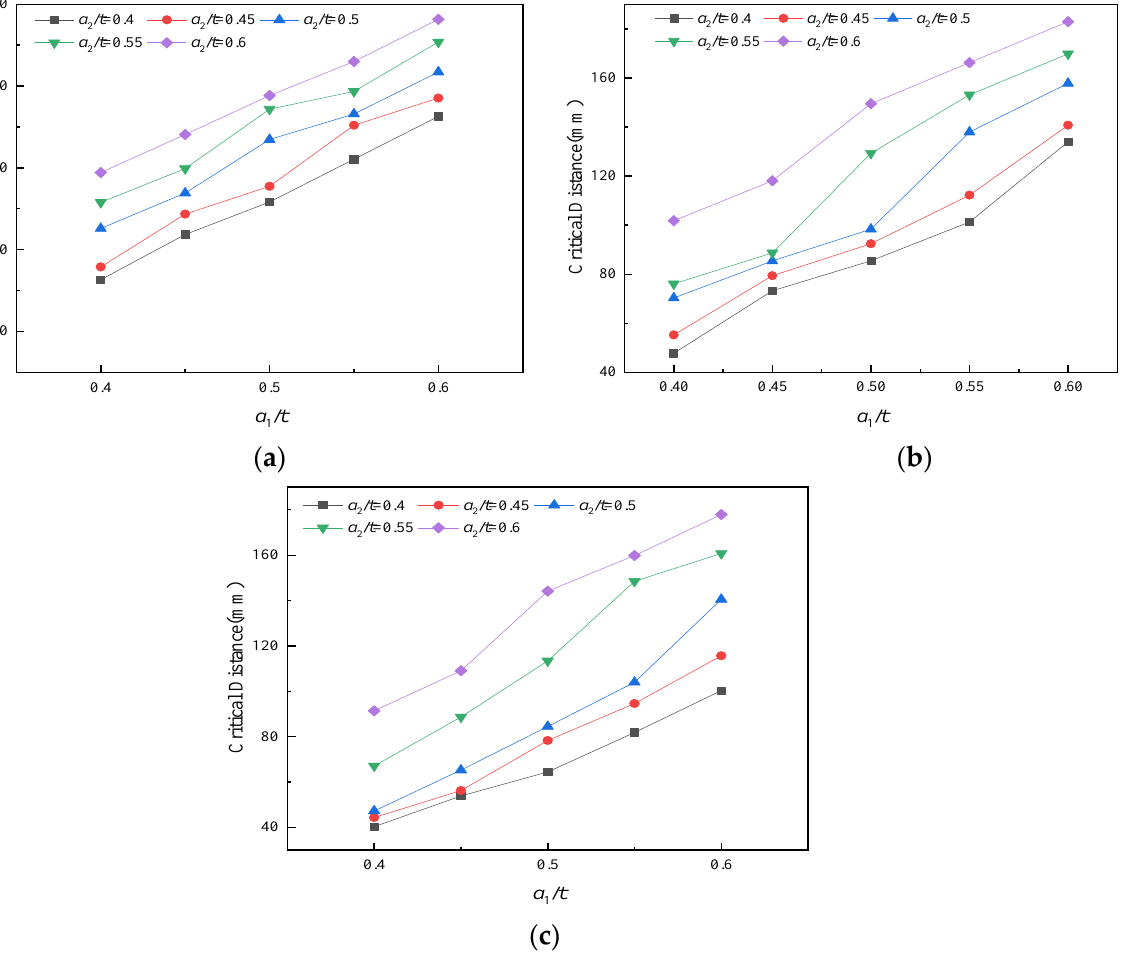
Figure 5. Diagram of impact of defect depth on the critical distance: ( a ) the exterior wall; ( b ) the interior wall; ( c ) the interior and exterior wall.